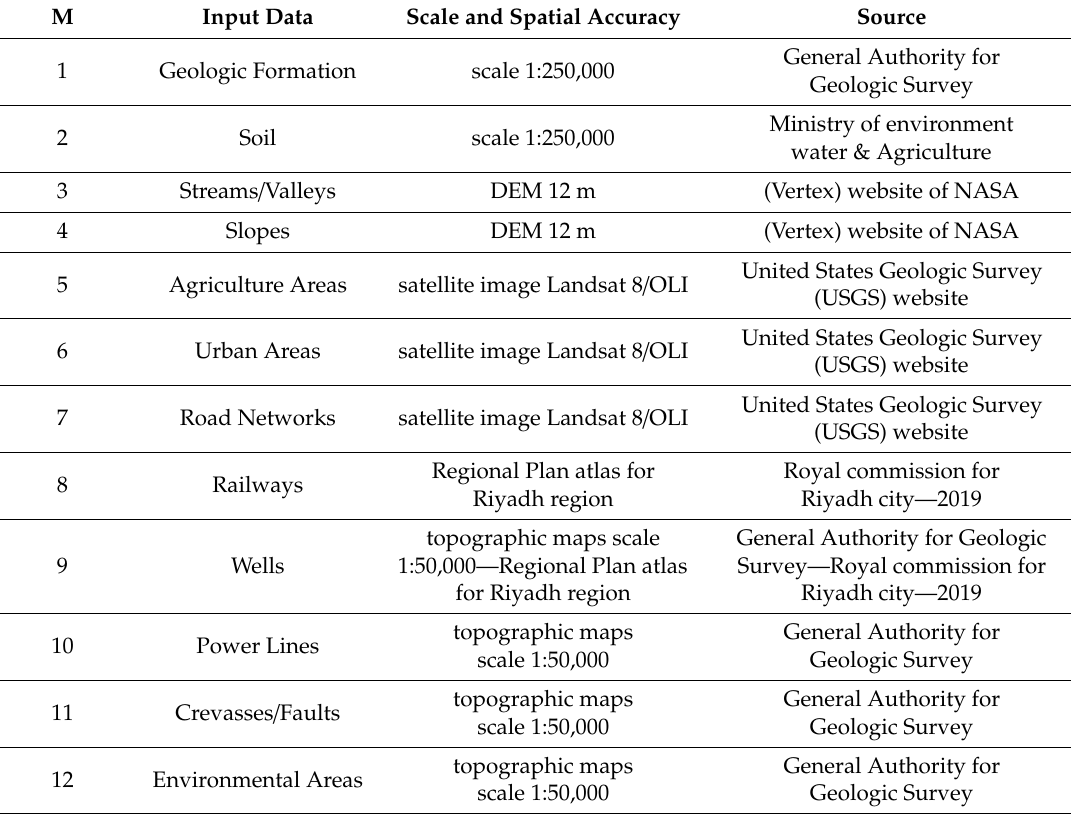
Table 1. The input data, spatial accuracy, and sources used in